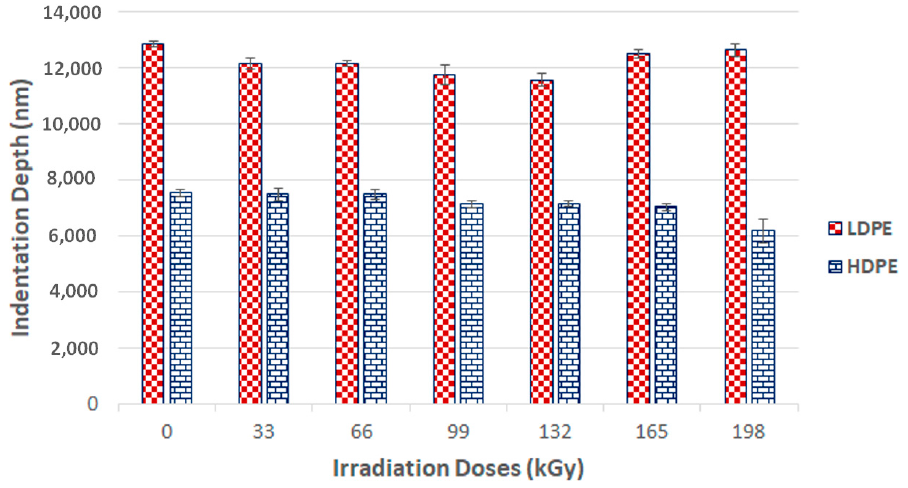
Figure 7. Indentation depth ( h max ) of irradiated LDPE and HDPE; the vertical line drawn at the top of the column represents the standard deviation.